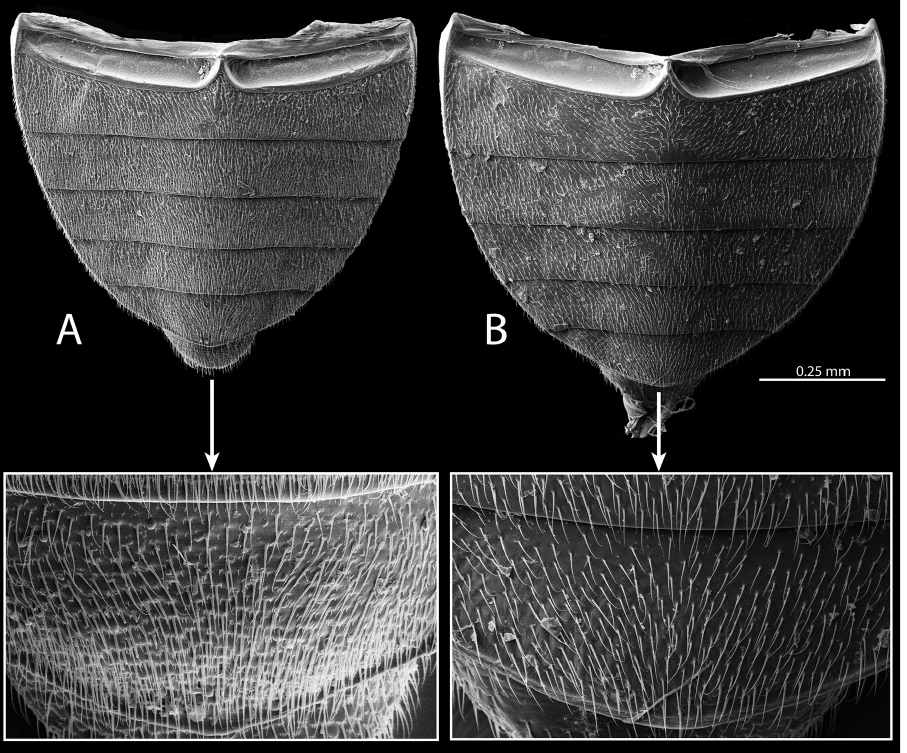
Figure 13. Abdominal ventrites of Tobochares spp. A T. kasikasima B T. canthus sp.